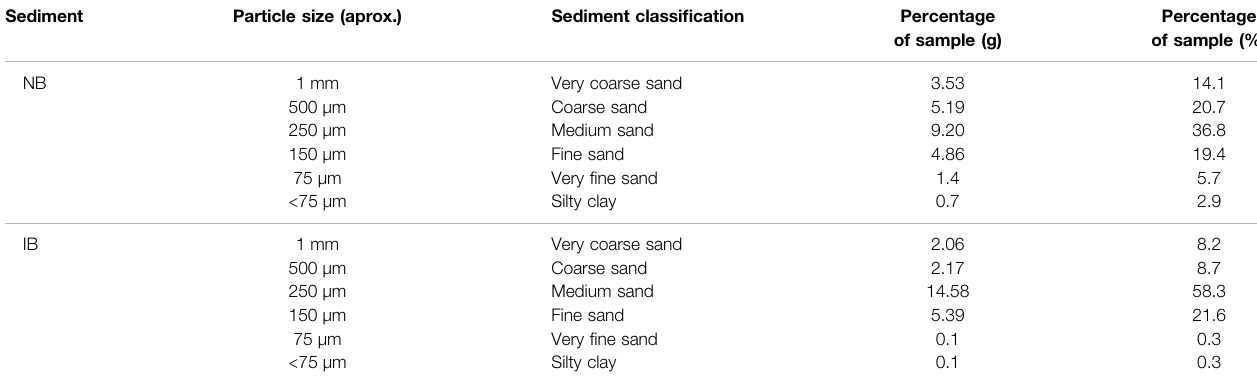
TABLE1| Granulometriccompositionofsediments(NB)and(IB)byparticlesize,sedimentclassi fi cationbyparticlesize,andamountofsedimentretainedinsieves(g)andin percentage (proportional to sample size 25 g). Sediment Particle size